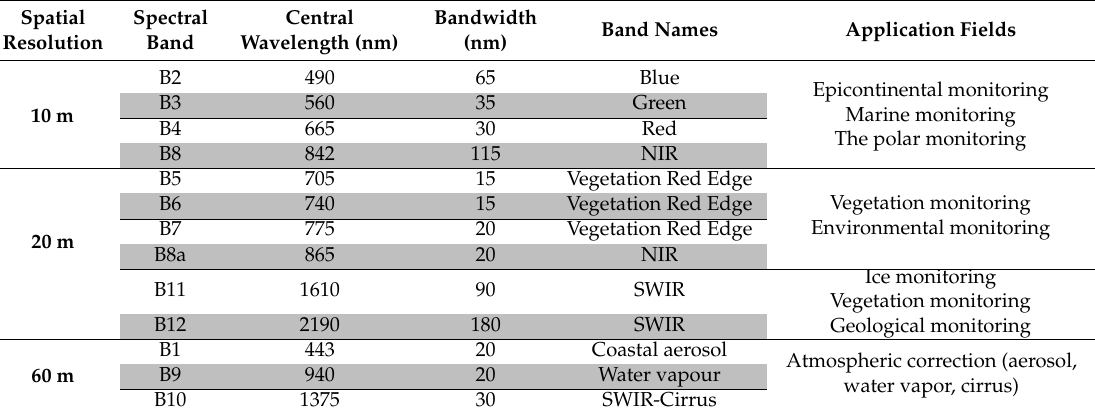
Table 1. Attributes of Sentinel-2 A / B satellite’s 13